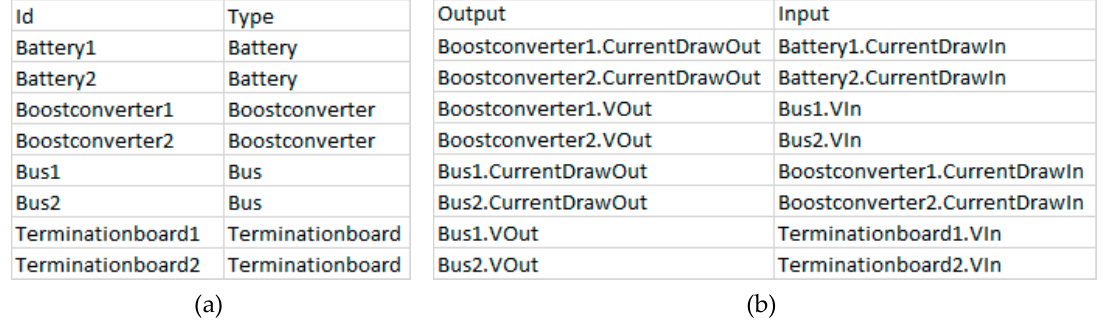
Figure 5. Example of a components table used to instantiate components ( a ) and a forward connector table used to connect component instances port wise ( b ).